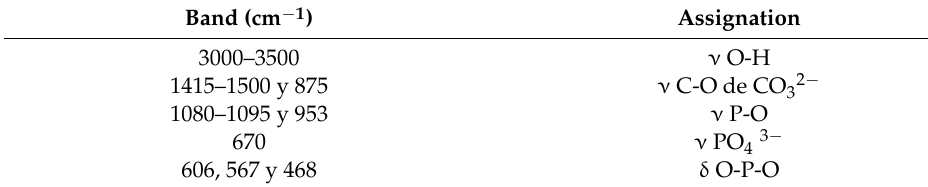
Table 3. Characteristics absorption bands of carbonated hydroxyapatite [32–38].